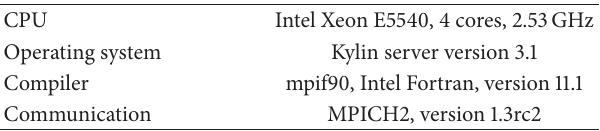
Table 1: Technical specifications of the experiment